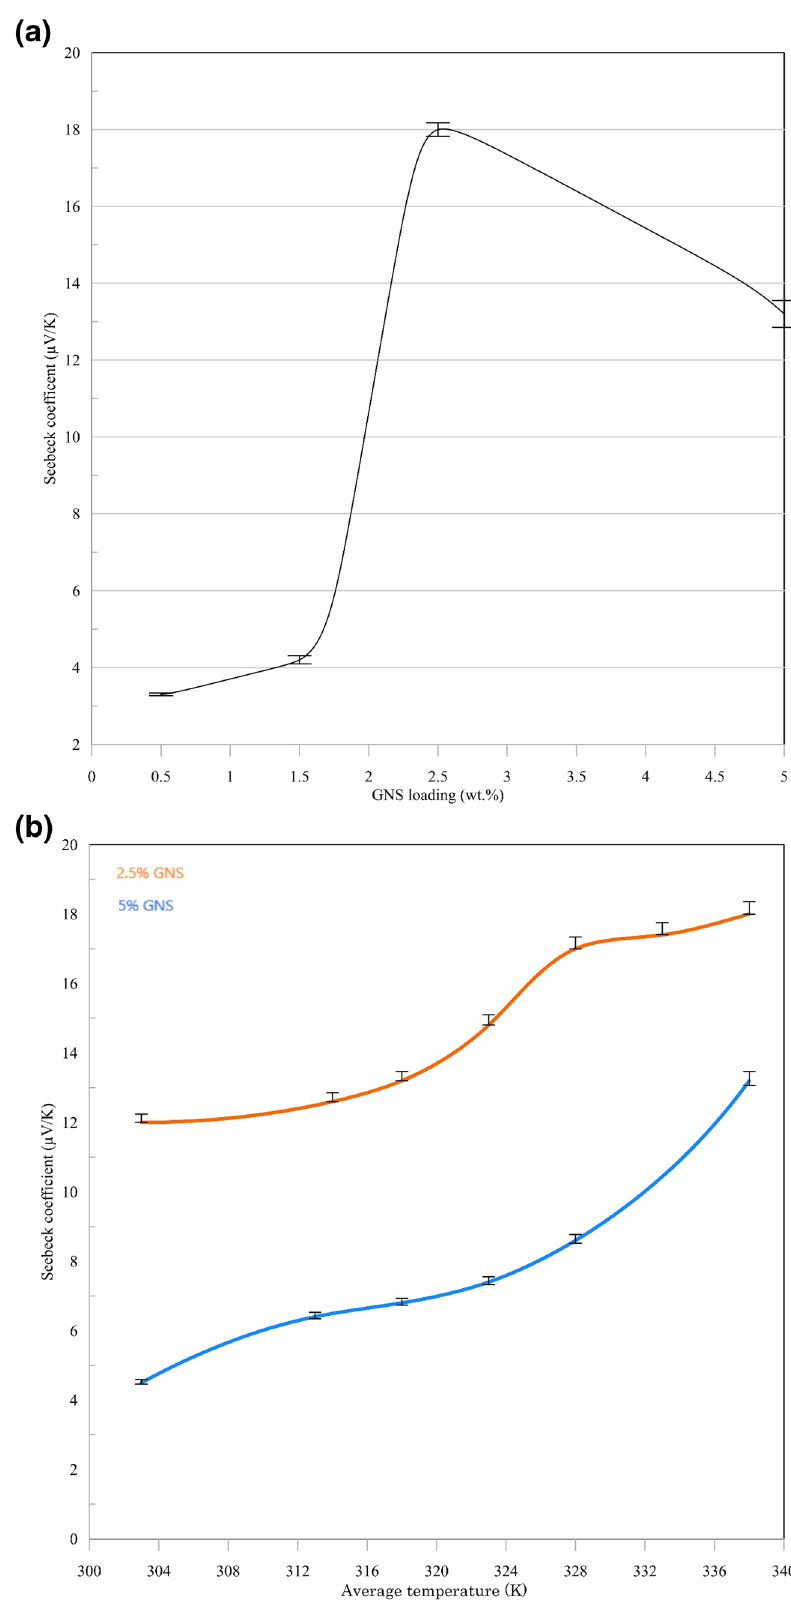
Fig. 7 a Seebeck coefficient as a function of wt% GNS measured at average temperature (338 K). b Seebeck coefficient for 2.5 and 5 wt% GNS samples as a function of average